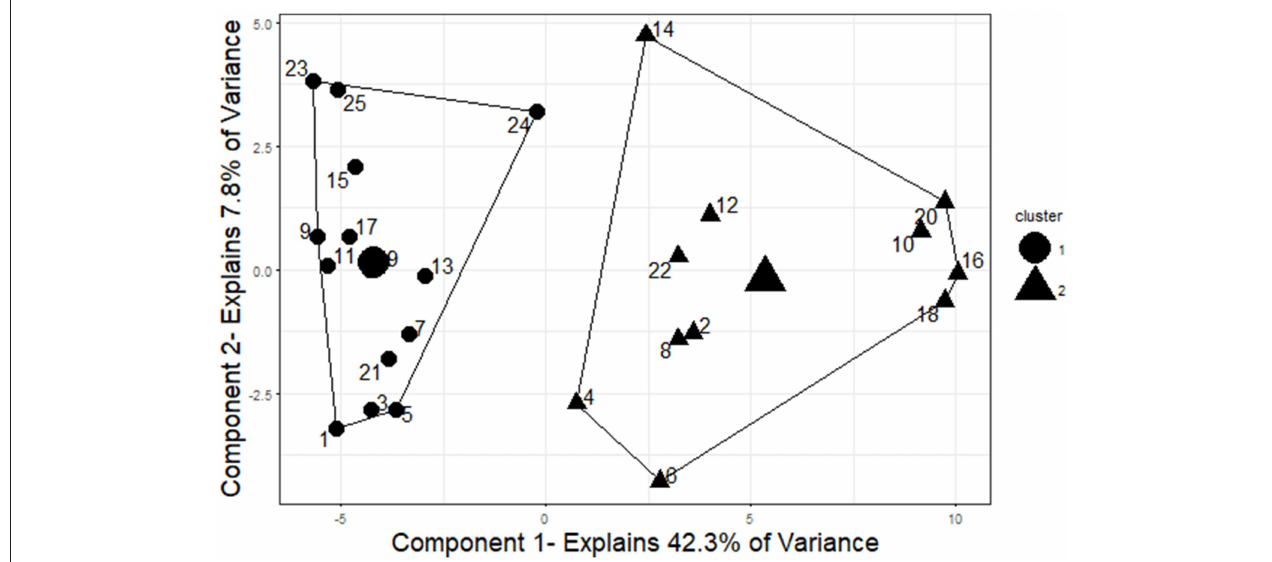
FIGURE 5 | Two-cluster solution for items. The two clusters represent good separation between disclosed (even-numbered) and undisclosed (odd-numbered) items. The cluster centers and cluster membership are indicated by shape (triangles represent the cluster of size 11 and circles represent the cluster of size 14). To visualize the cluster results, components were obtained using principal component analysis, and the clusters are plotted on those components. This plot was created using the “fviz_cluster” function in the “factoextra” package of R (Kassambara and Mundt,